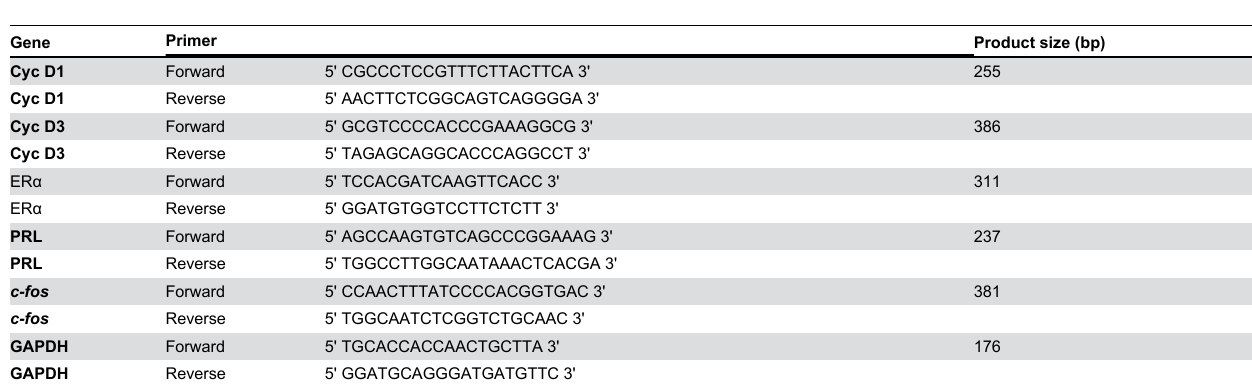
Table 1. Primers used for semi-quantitative RT-PCR assays.